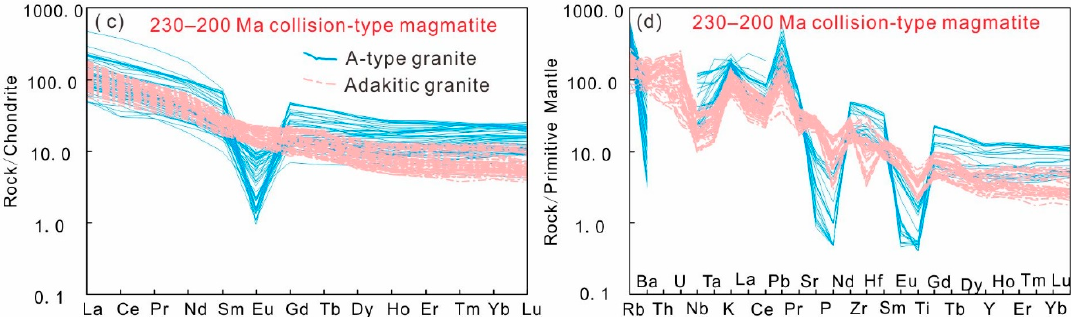
Figure 11. ( a ) Chondrite-normalized REE patterns for arc magmatic rocks; ( b ) primitive mantle- normalized trace element spider diagrams for arc magmatic rocks; ( c ) chondrite-normalized REE patterns for collisional-type rocks; ( d ) primitive mantle-normalized trace element spider diagrams for collisional-type rocks. Normalized values for chondrite and primitive mantle are from Boynton et al. [118] and Sun and McDonough [119], respectively. Geochemical data are presented in Supplementary Table S2.